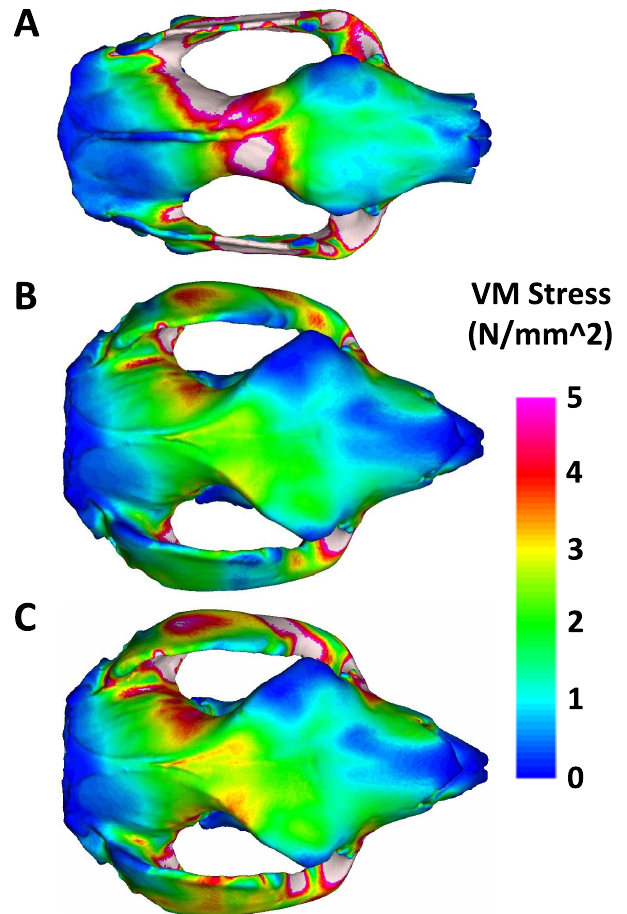
Fig 4. Finite element models depicting Von Mises stress magnitudes during a unilateral premolar bite in (A) the koala, (B) Simosthenurus occidentalis with tree-kangaroo muscle proportions, and (C) S . occidentalis with tree- kangaroo muscle proportions and enlarged ZM